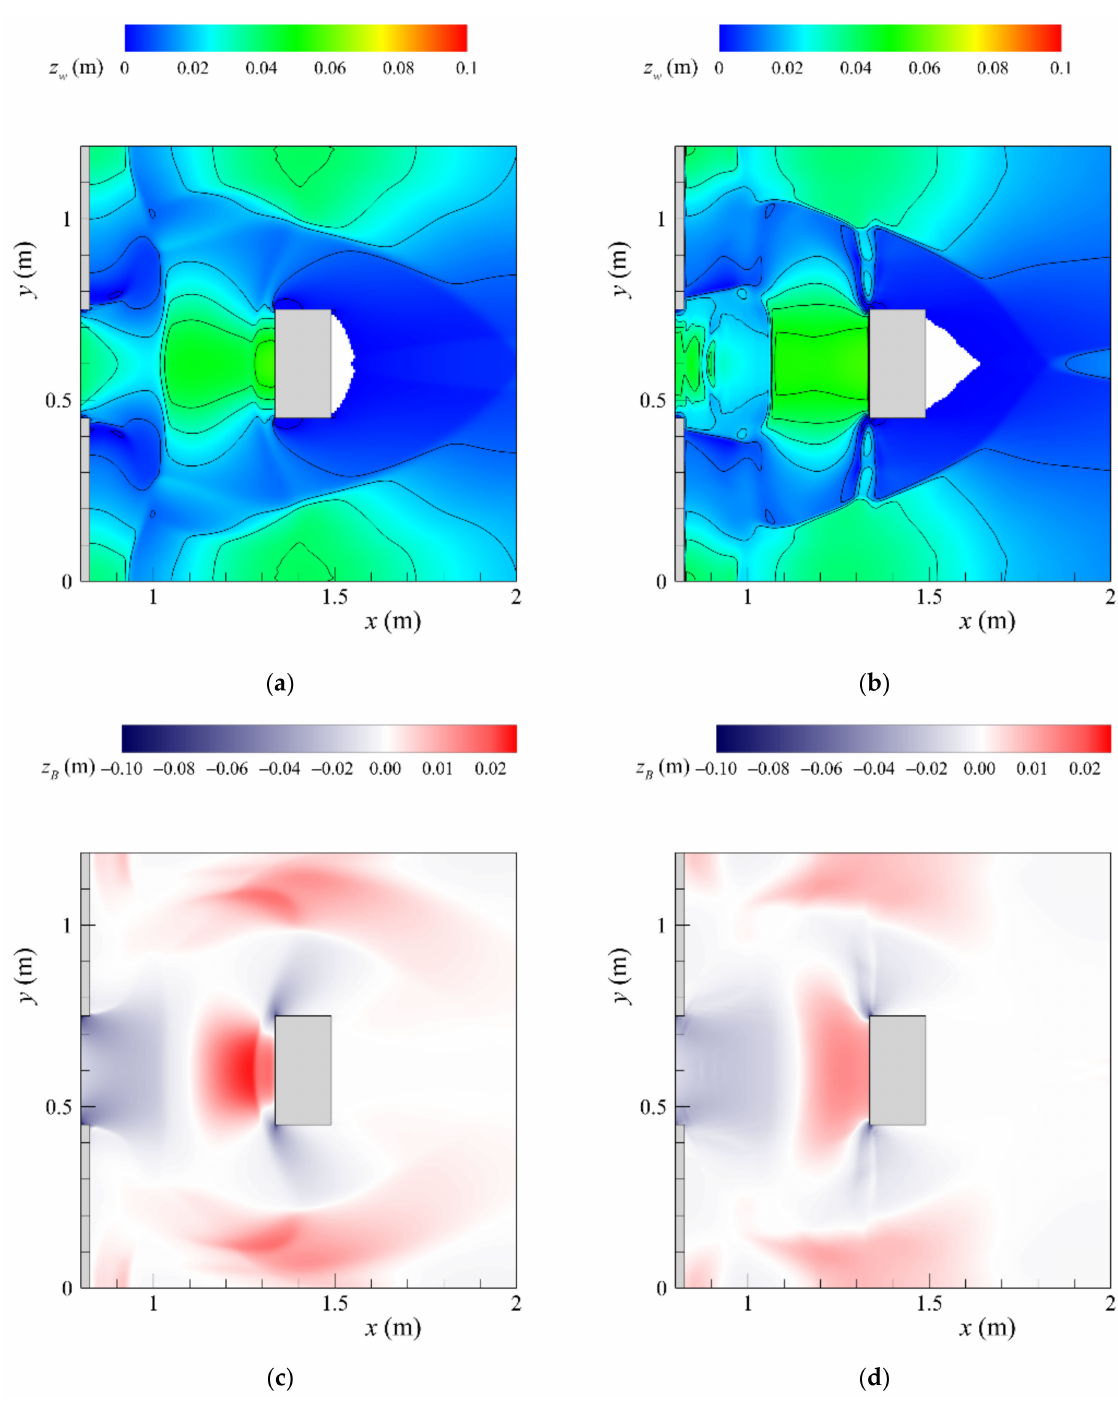
Figure 11. Results for PVC particles d = 5 × 10 − 4 m at t = 3.0 s: ( a ) free-surface elevation predicted by the SVEM; ( b ) free-surface elevation predicted by the TPM; ( c ) bottom elevation predicted by the SVEM; ( d ) bottom elevation predicted by the